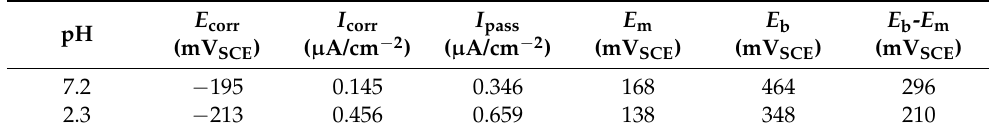
Table 5. The parameters from the polarization curves of 304 SS in 0.6 mol/L NaCl